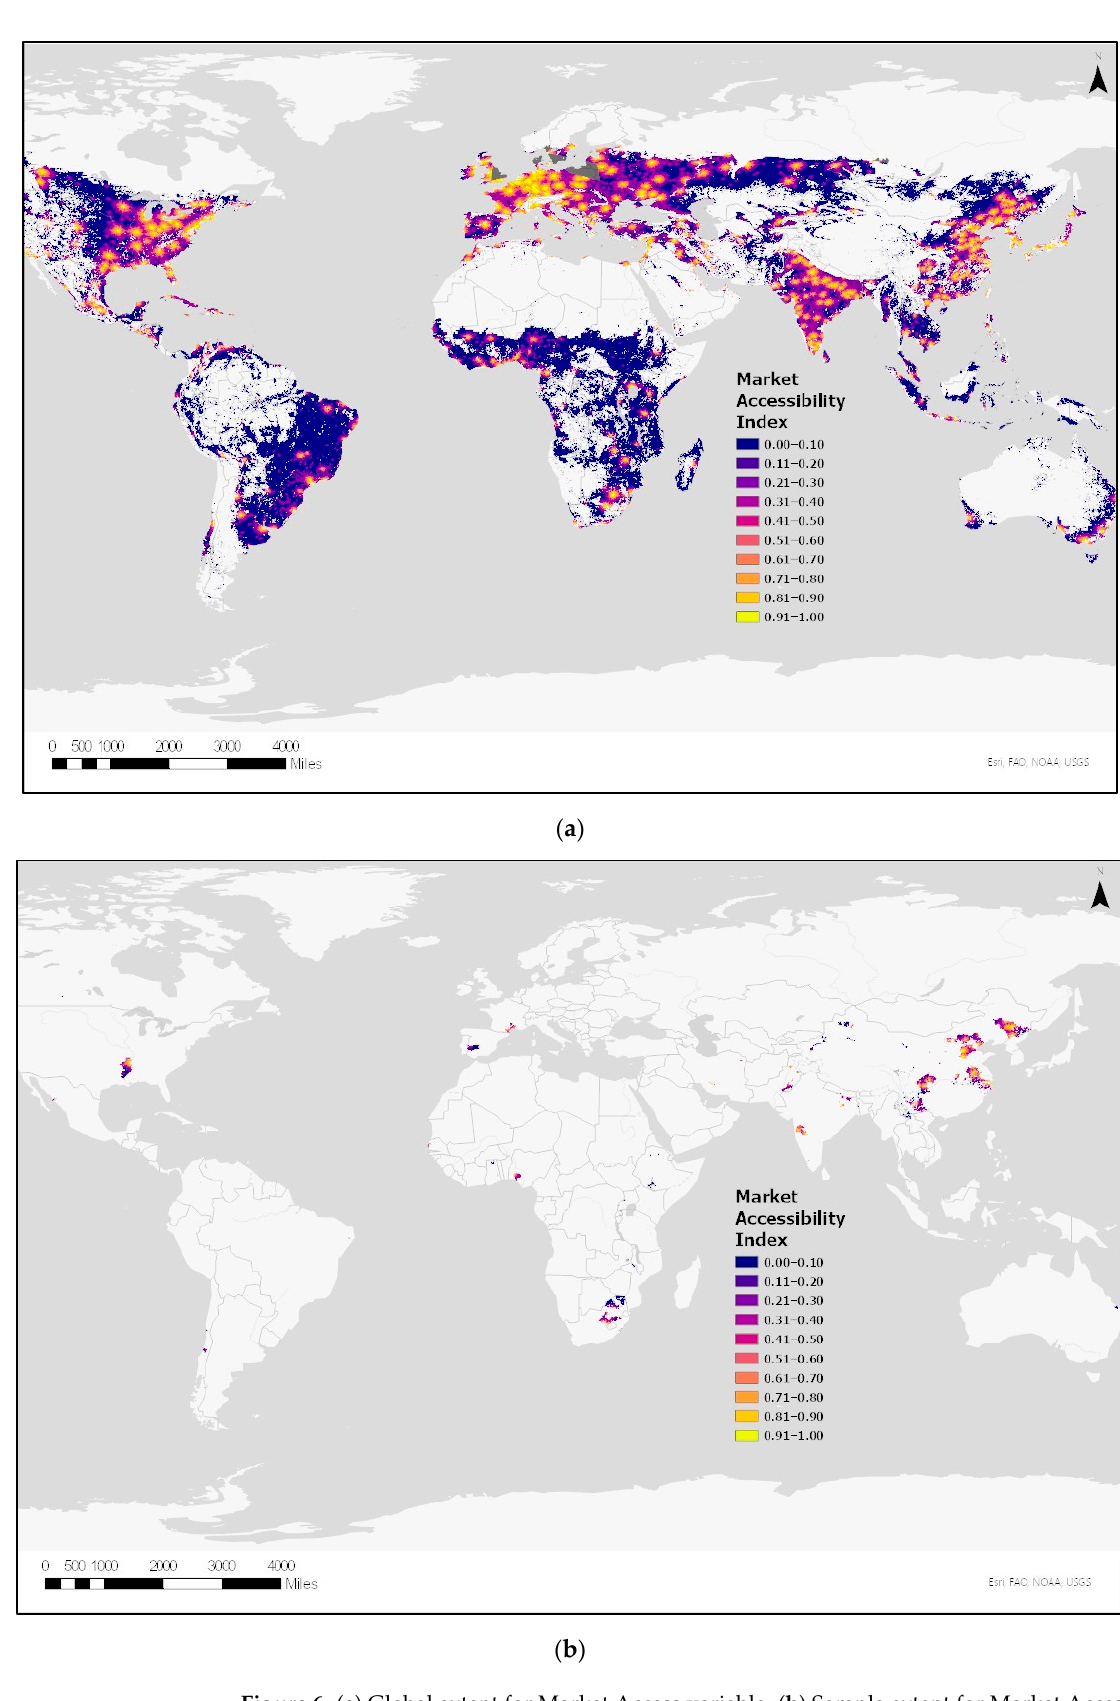
Figure 6. ( a ) Global extent for Market Access variable. ( b ) Sample extent for Market Access variable.